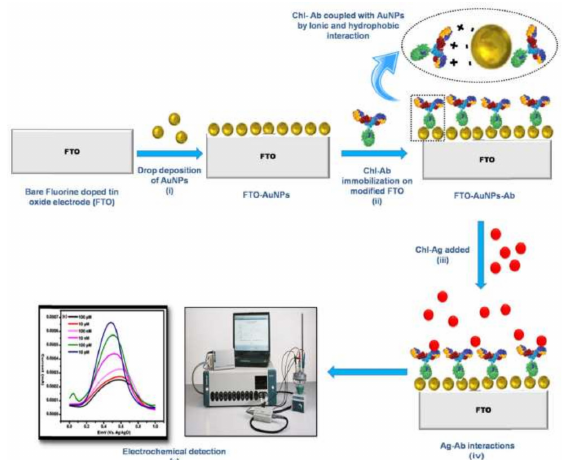
Figure 6. Anti-chlorpyrifos immobilized on fluorine-doped tin oxide with gold nanoparticles to direct determination of chlorpyrifos (reprinted with permission from